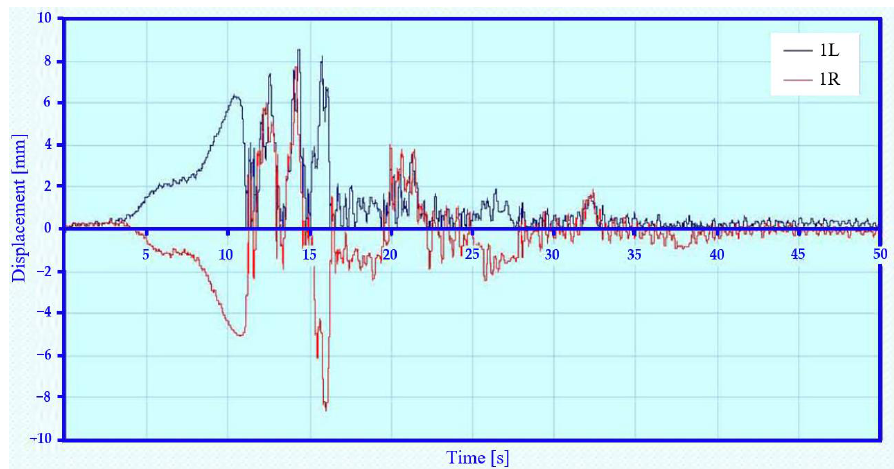
Figure 18. Relative displacement between chassis frame and wheelset—variant B-III.